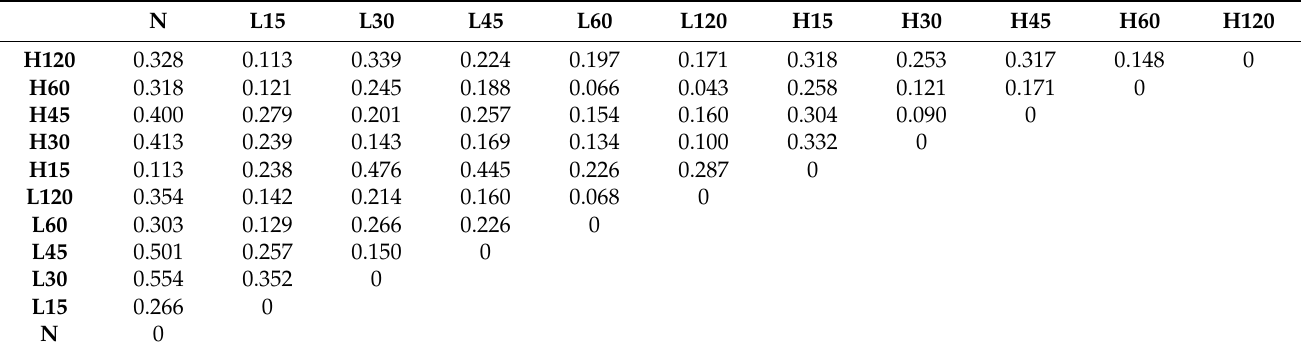
Table 3. The total color difference between starches ( ∆